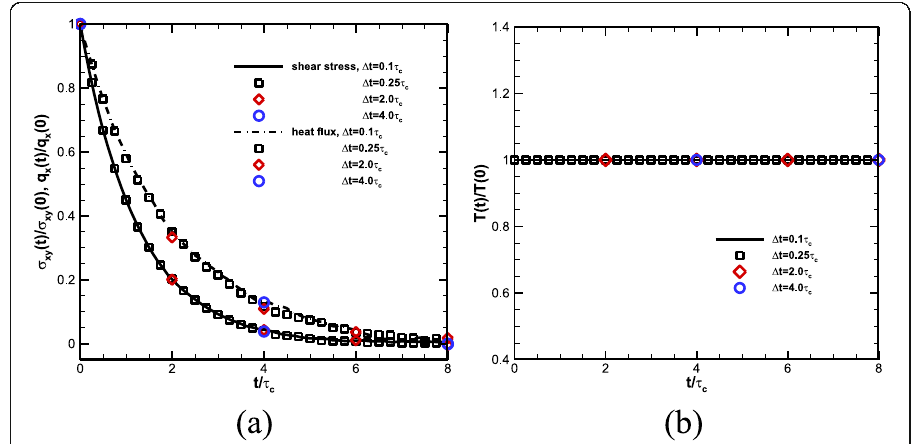
Fig. 1 a relaxation of shear stress and heat flux; b temperature evolution in the homogeneous flow with four different time step size Δ t ∈ {0.1 τ c , 0.25 τ c , 2.0 τ c , 4.0 τ c